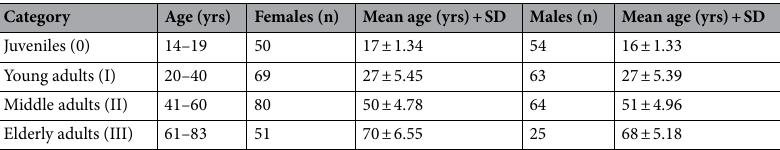
Table 1. Age categories used in the